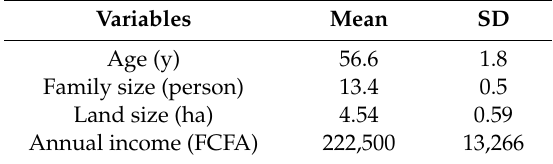
Table 2. Average age, family size, land size, and annual income of